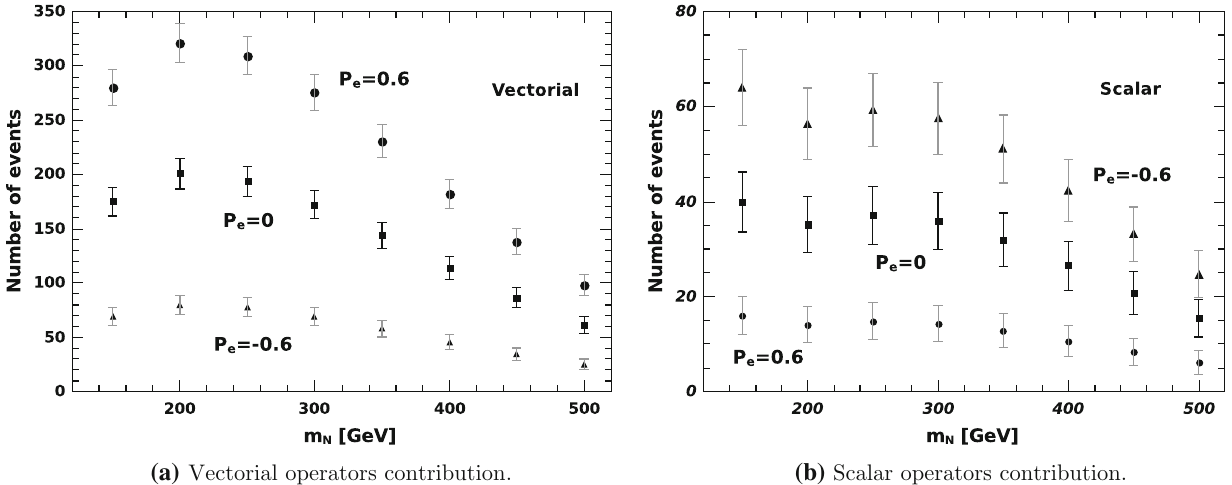
Fig. 9 Number of events and error bars for the signal with P e = − 0 . 6 , 0 and 0 . 6. Here L = 100 fb − 1 . a Vectorial operators contribution. b Scalar operators contribution